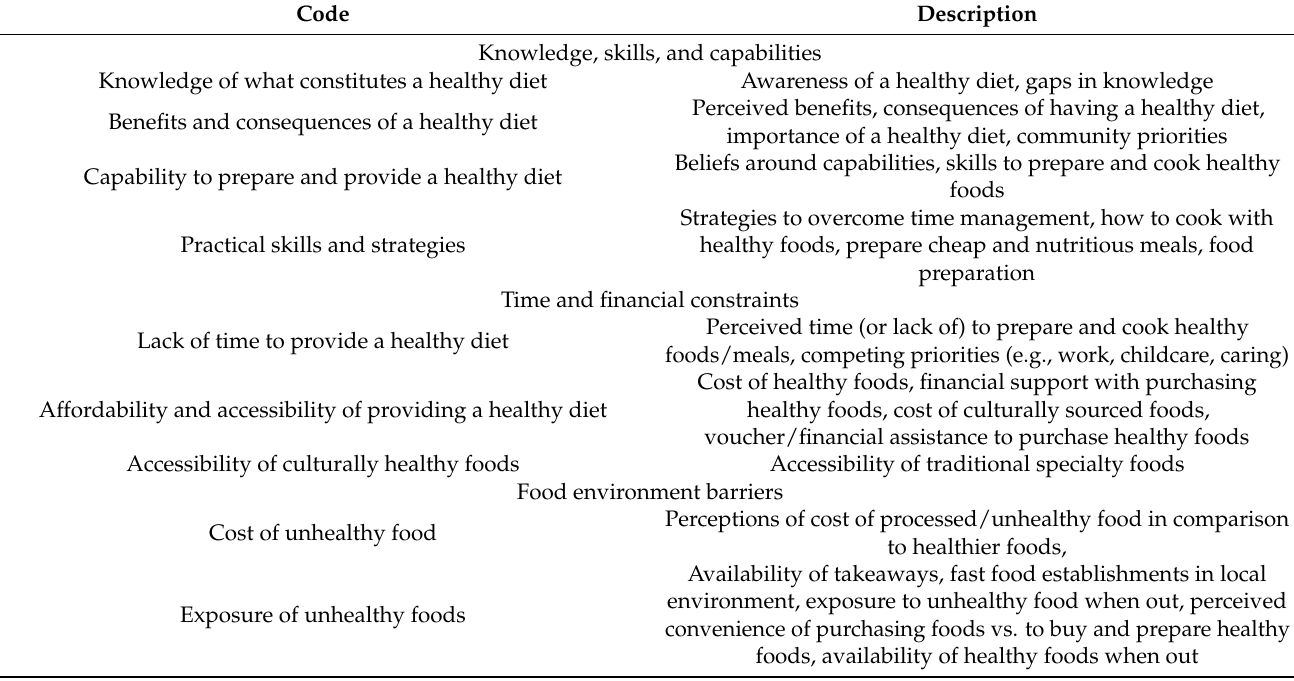
Table 2. Analytic coding framework with